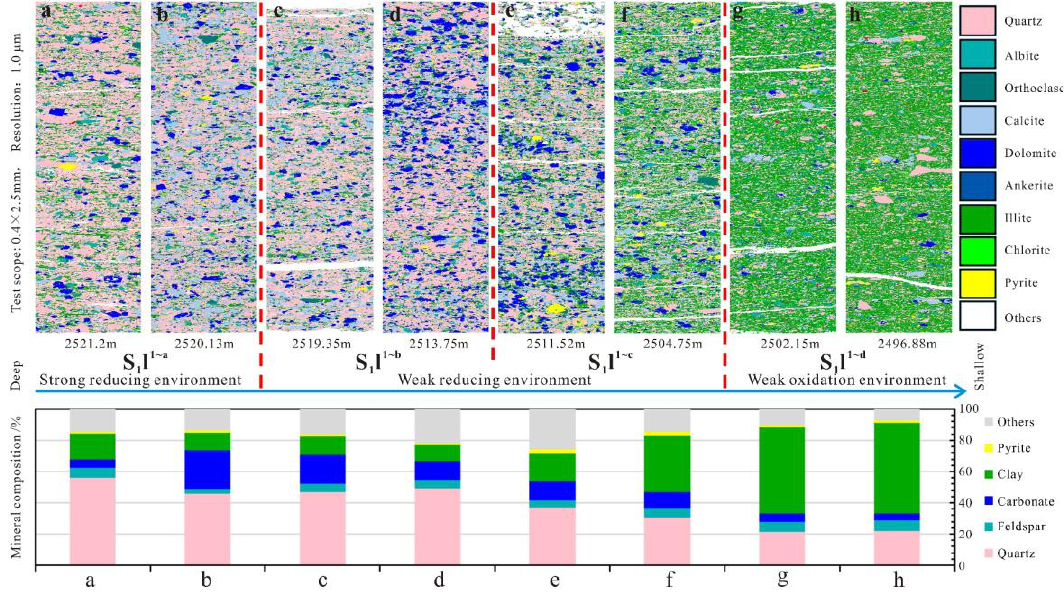
Figure 10. Characteristics of mineral composition and distribution of shale in different sections analysis by QEMSCAN.